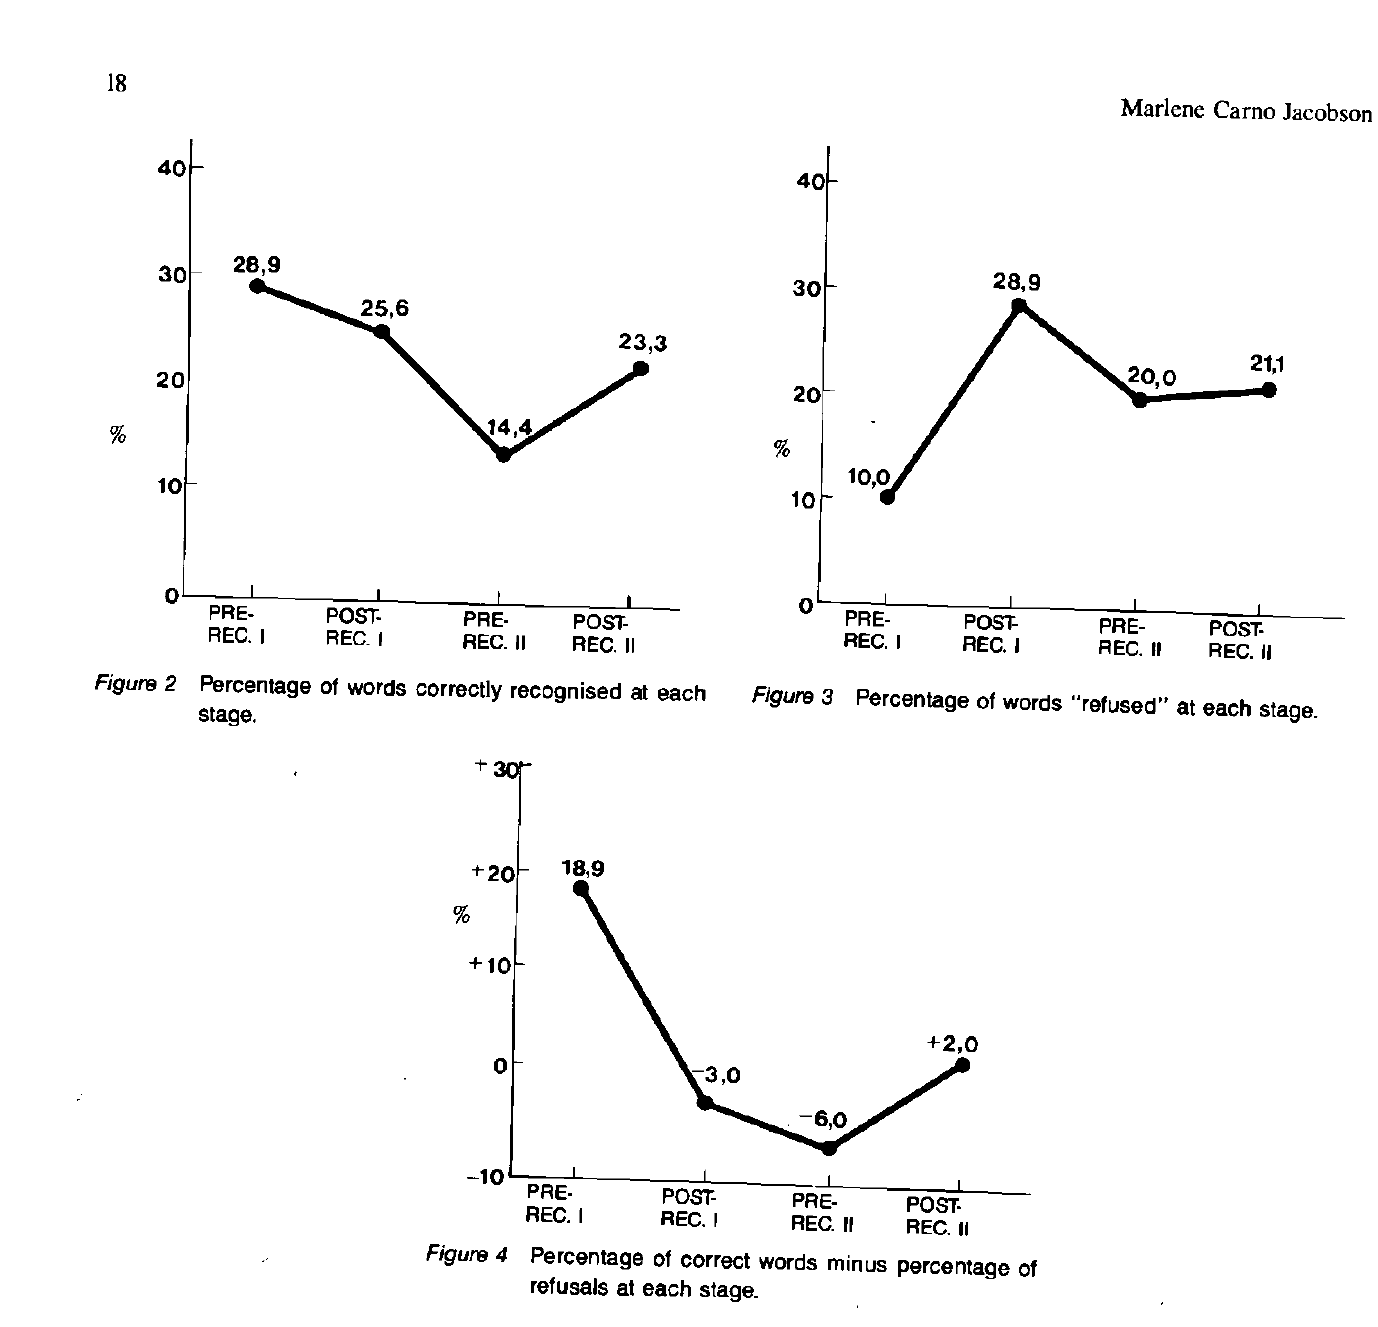
Figure 4 Percentage of correct words minus percentage of refusals at each